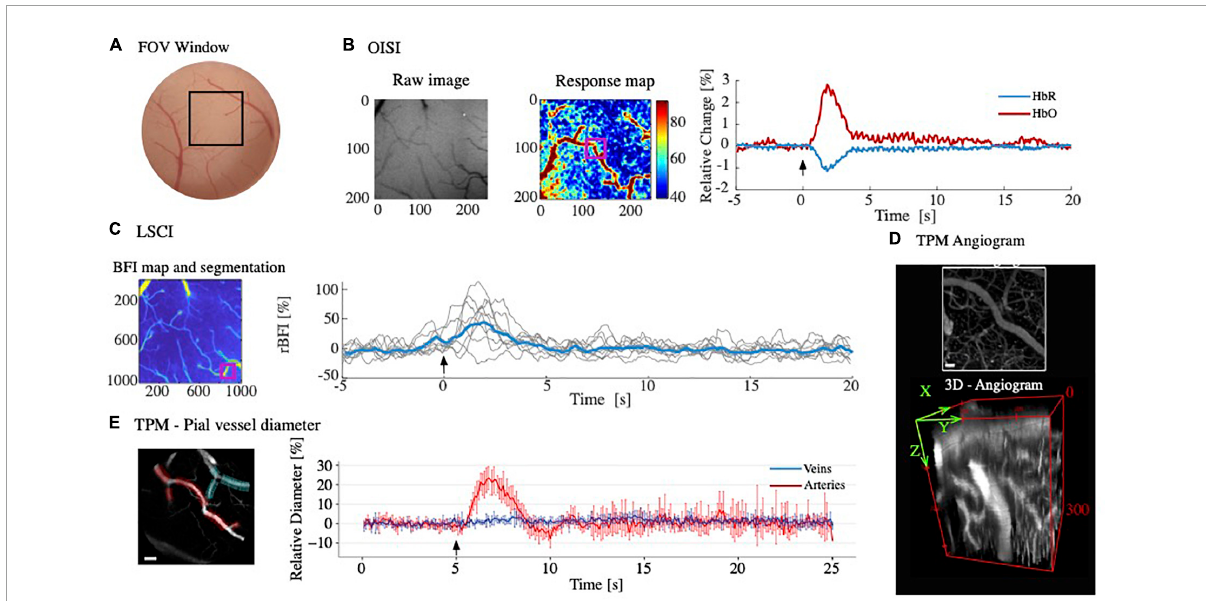
FIGURE7 Acquired data from optical imaging. (A) Field of view with outlined region of interest used for OISI, LSCI, and TPM (black square); (B) OISI raw image ( left ) and response map ( middle ) as relative change from baseline (%). A region of interest (ROI; purple) was selected in the response map to plot relative changes as a function of time for HbR (blue) and HbO (red). The expected increase in HbO and decrease in HbR are seen as a result of stimulation (black arrow); (C) LSCI blood flow index (BFI) map and segmentation based on average contrast analysis from raw speckle signal. Relative BFI (rBFI) of an ROI (purple square) is plotted as a function of time from the intensity in each pixel of the signal and shows increased flow with stimulation (black arrow); (D) TPM maximum intensity projection and 3D angiogram used to visualize depth of imaging permitted with the cranial window; (E) TPM visualization of pial vessel diameters ( left ) and relative changes in pial vessel networks as a function of time ( right ). Estimations were performed using Vasometrics plugin in ImageJ, averaging all vessel branches from the arterial (red in left ) and venous (cyan in left) networks selected from the TPM time-series. Upon activation (black arrow) arterial network showed an increase in diameter (red in right ), whereas venous network was unresponsive to stimulation (blue in left ). Scale bar = 50 µ